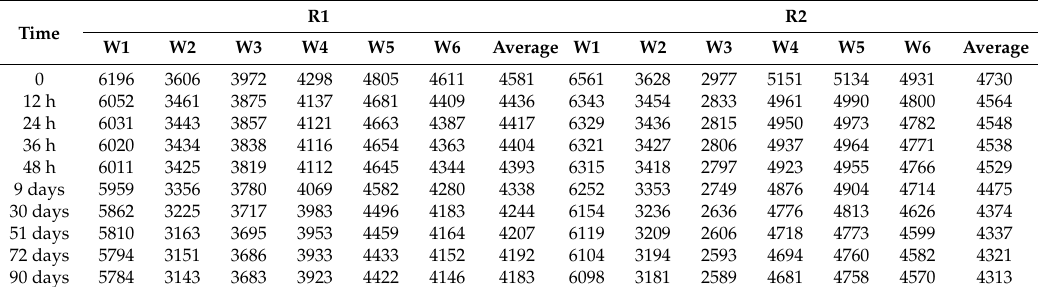
Table 13. The monitored strains of the strands at the in-service stage. (Unit: µε ). Time